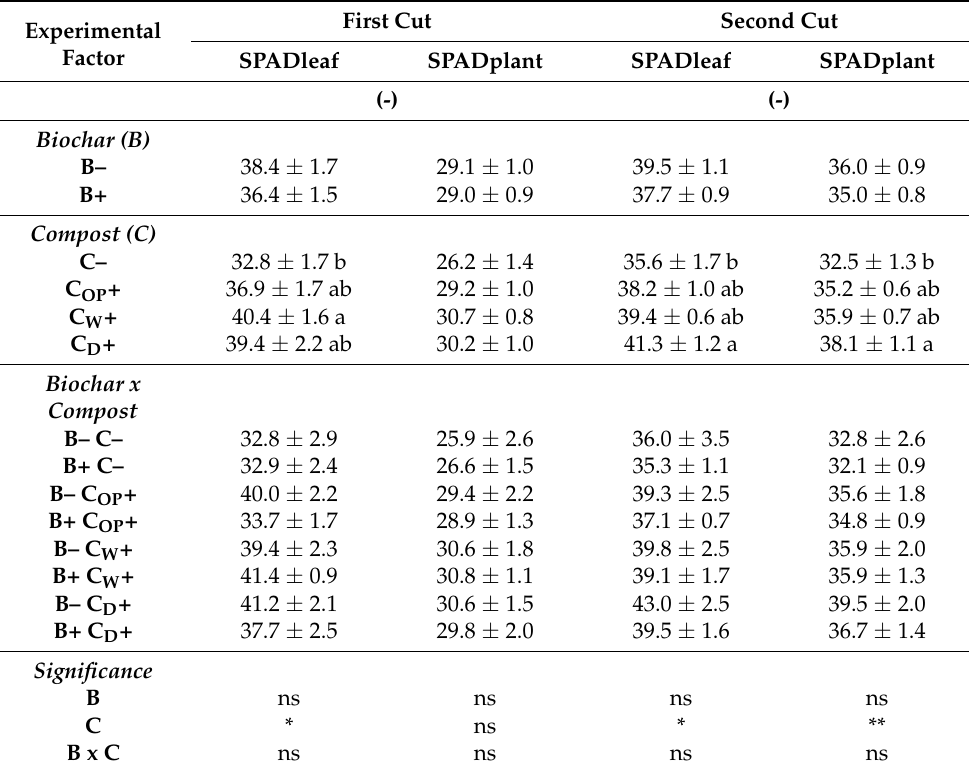
Table 5. Effect of biochar, compost and biochar x compost interaction on SPAD meter values relatively to the youngest fully expanded leaf (SPADleaf) and the whole plant leaves (SPADplant), at the first and the second cut Swiss